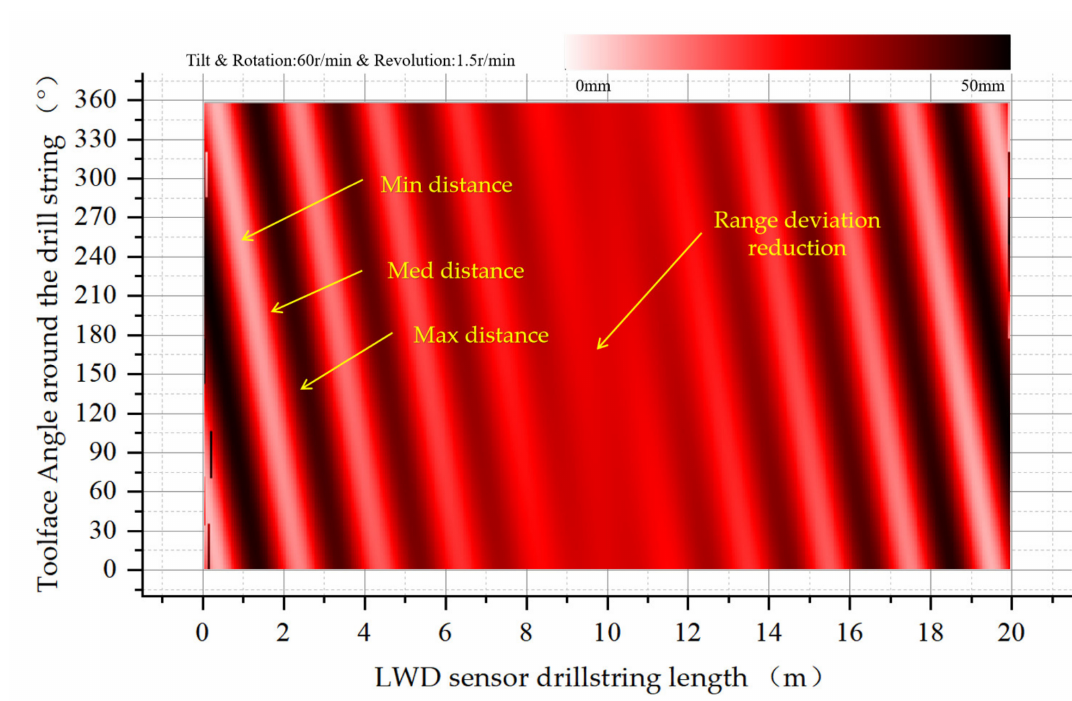
Figure 13. Eccentricity distribution of drill collars in the wellbore. with oblique rotation and additional revolution at a speed of 1.5 RPM.